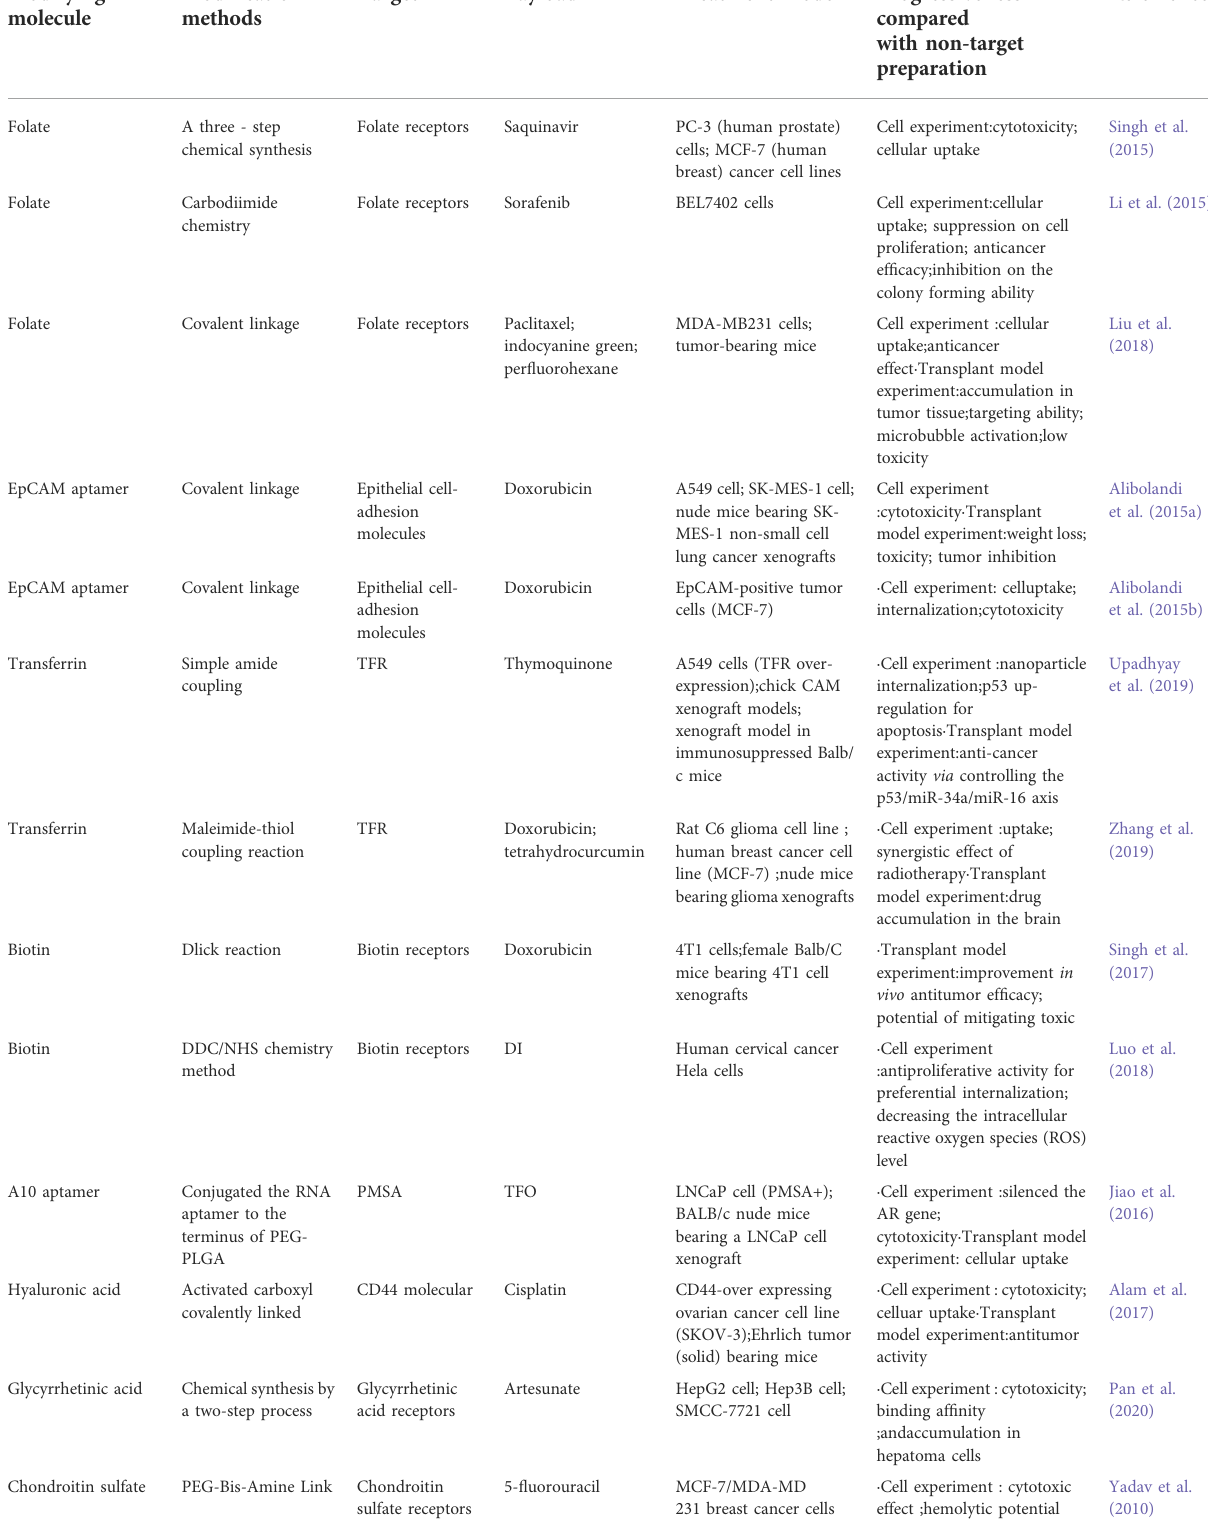
TABLE 2 Recent applications of ligand-modi fi ed PEG-PLGA nanoparticles as drug carriers for actively targeted cancer